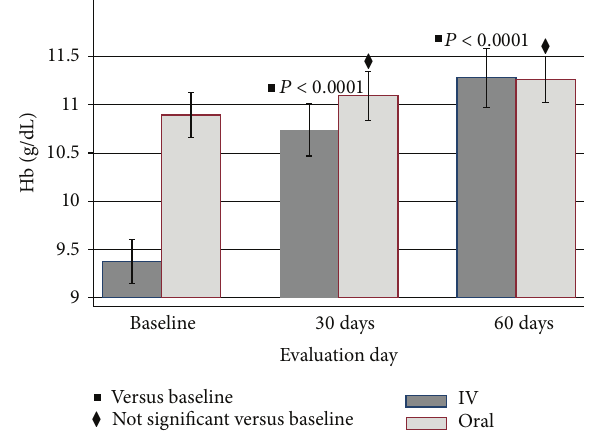
Figure 2: Mean hemoglobin levels ± SD by treatment group over durationofstudy. 𝑃 valuescompare30and60daystobaselinevalues for the IV